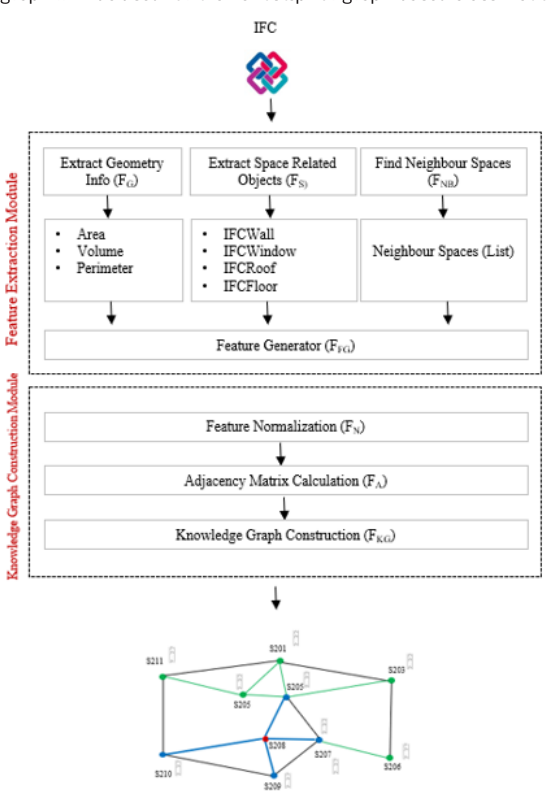
Figure 1 . Knowledge Graph